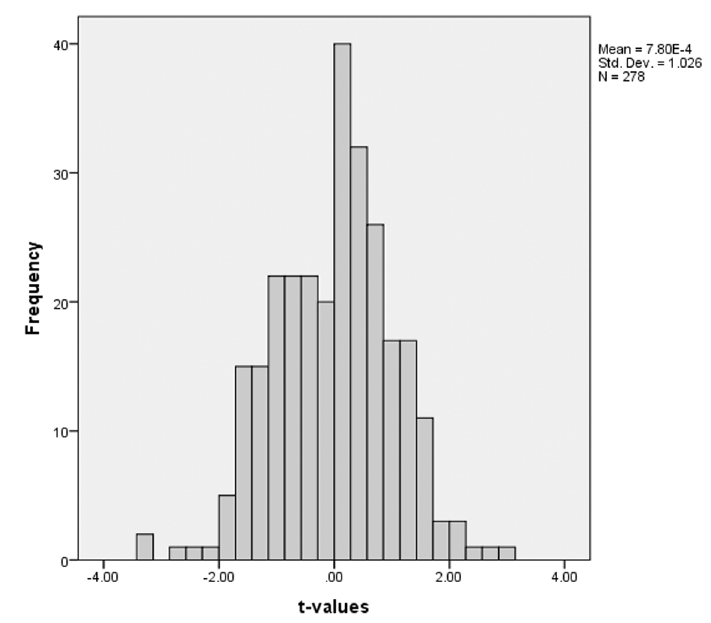
Figure 3. Distribution of t-values (2).